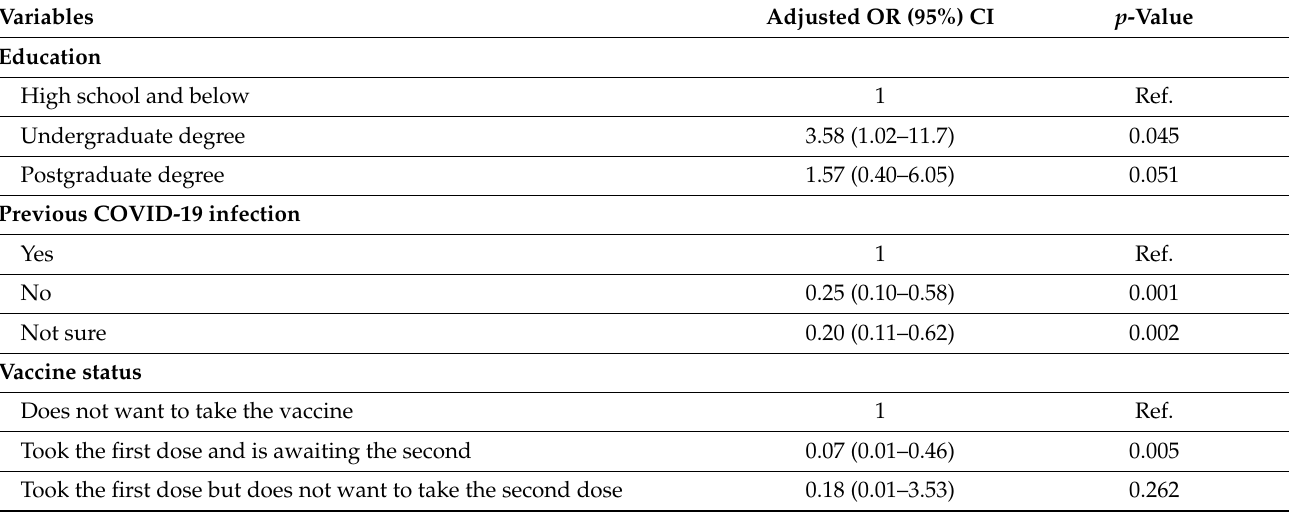
Table 3. Multiple logistic regression analysis final model of the parents’ intention to give COVID- 19 vaccine and various covariates with adjusted odds ratio (OR) and adjusted 95% confidence interval